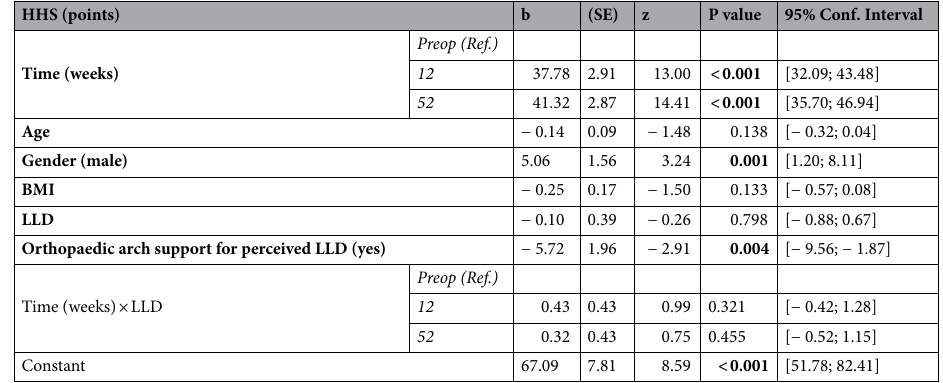
Table 4. Linear mixed effects model on change of HHS over time (n = 94). Coefficients (b), standard errors (SE), z-values, p-values, and 95% confidence intervals given. HHS Harris Hip Score, BMI body mass index, SE standard error, LLD leg length discrepancy.